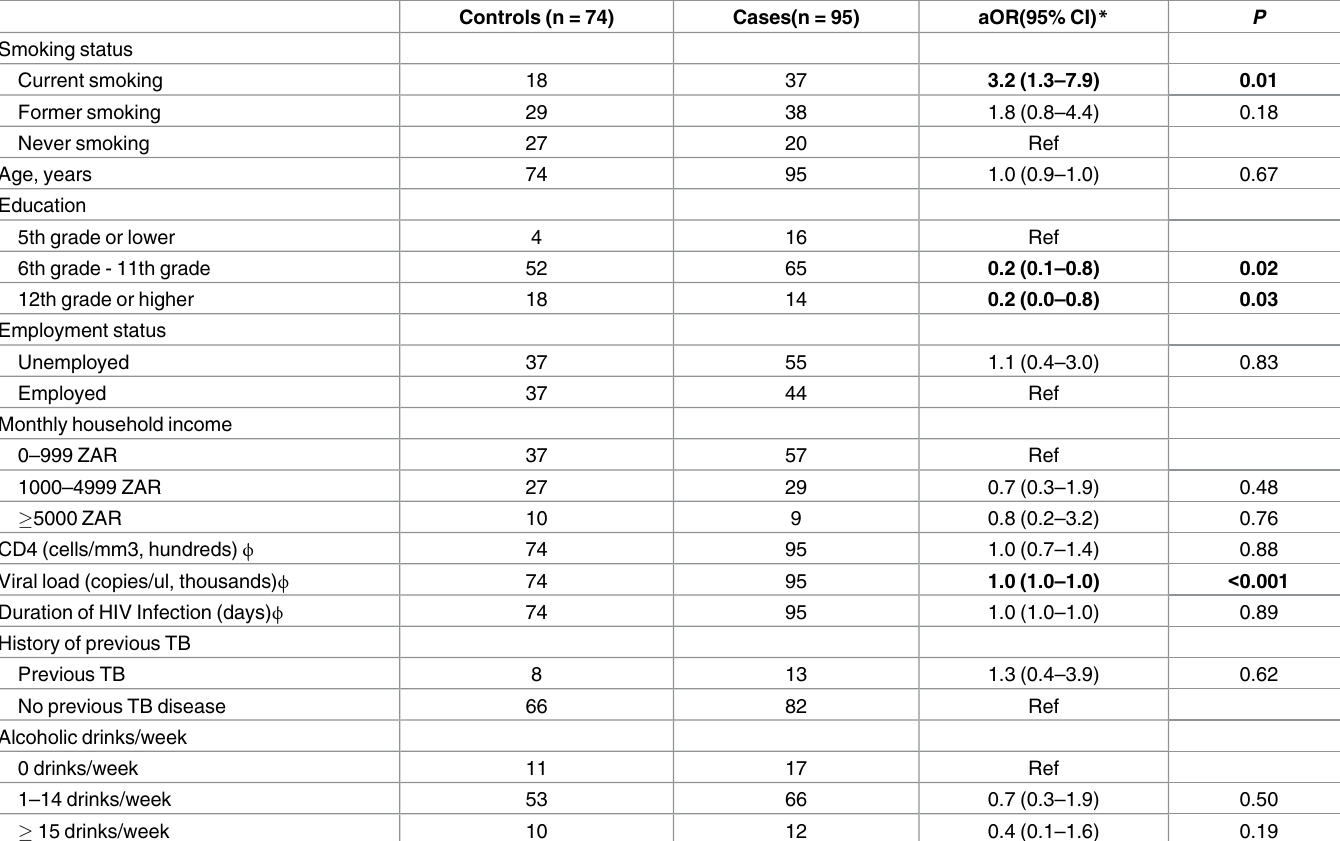
Table 3. Association of pulmonary TB with smoking history among men with HIV in Soweto (n =